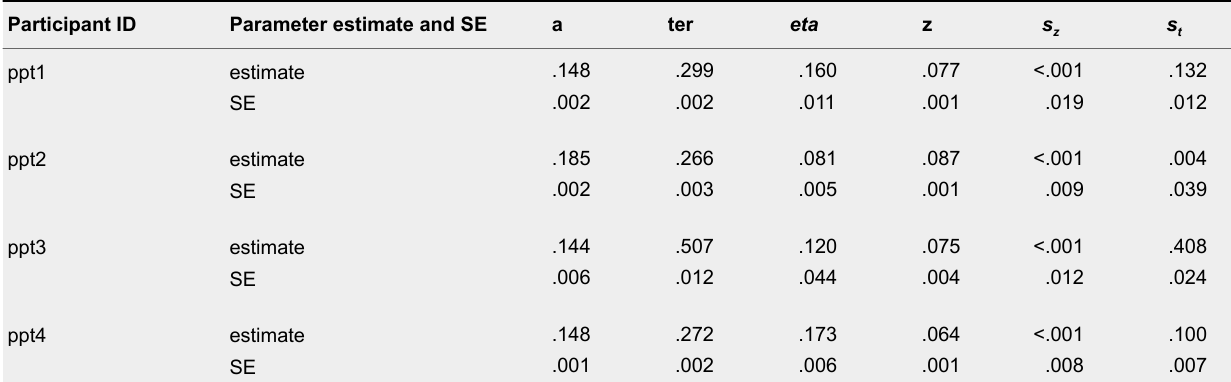
Estimates and Standard Errors of a, ter, eta, z, s z and s t for Each Participant (Abbreviated 'ppt'). Participant ID